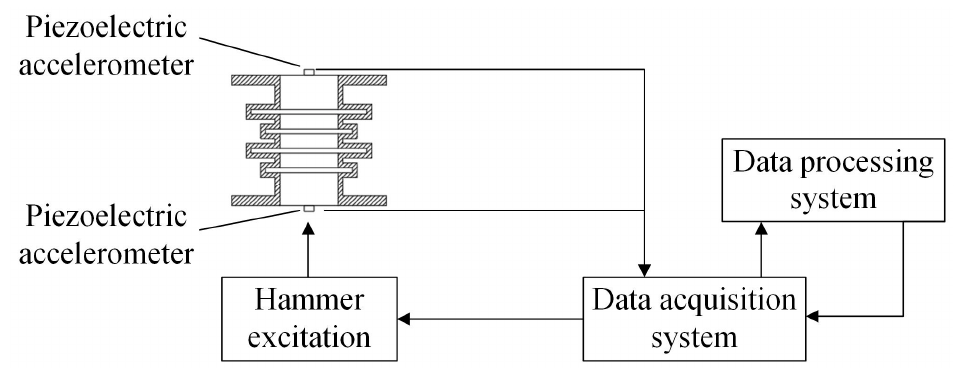
Figure 4. Hammer experiment process block diagram.